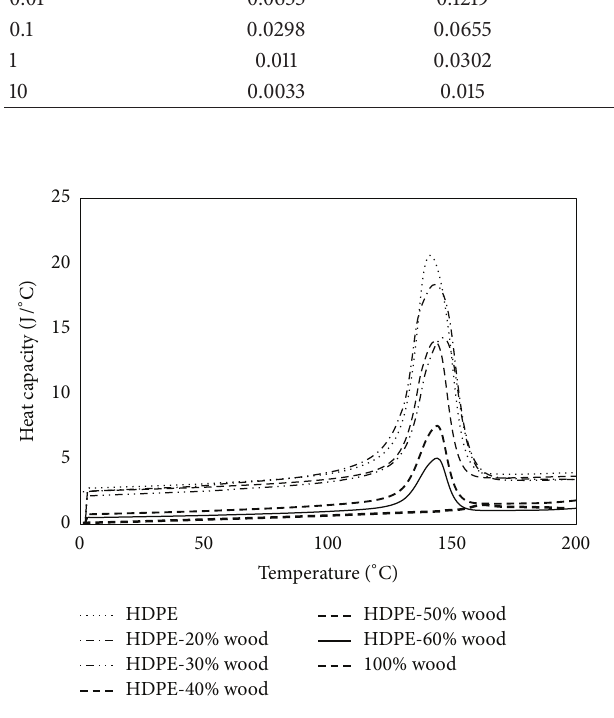
Figure 3: Change of heat capacity of HDPE-wood composite as function of temperature.